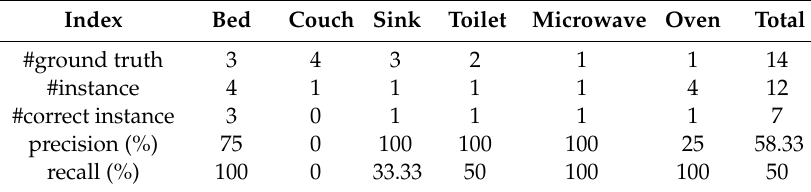
Figure 17. The results of the anto scene: ( a ) original point cloud, ( b ) point cloud with bounding rectangles, ( c ) the ground truth, and ( d ) the object semantic grid map. Table 4. The statistical results of the anto scene.